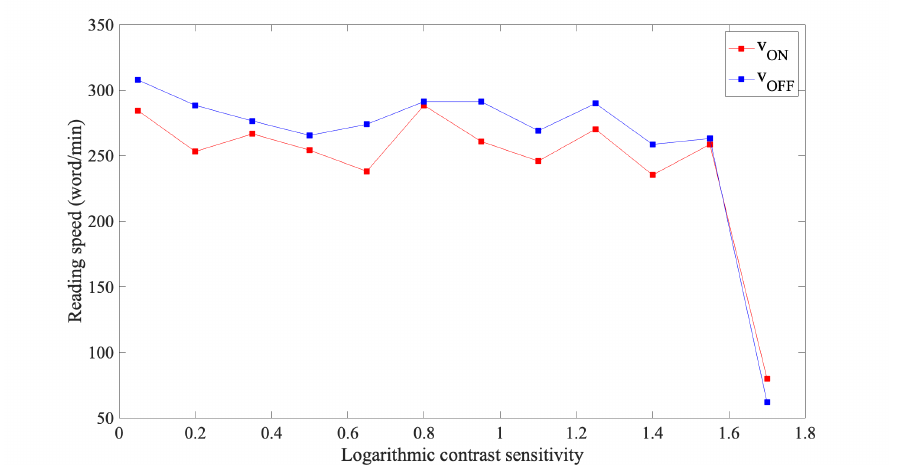
Figure 5. Reading speed depending on the logarithmic contrast sensitivity of subject 1 with the REX test. Observing the performance of subject 1, when the logarithmic contrast sensitivity is equal to 1.55, the reading speed values abruptly decrease. When this occurs, the critical contrast sensitivity value has been reached, beyond which the subject is unable to successfully complete the